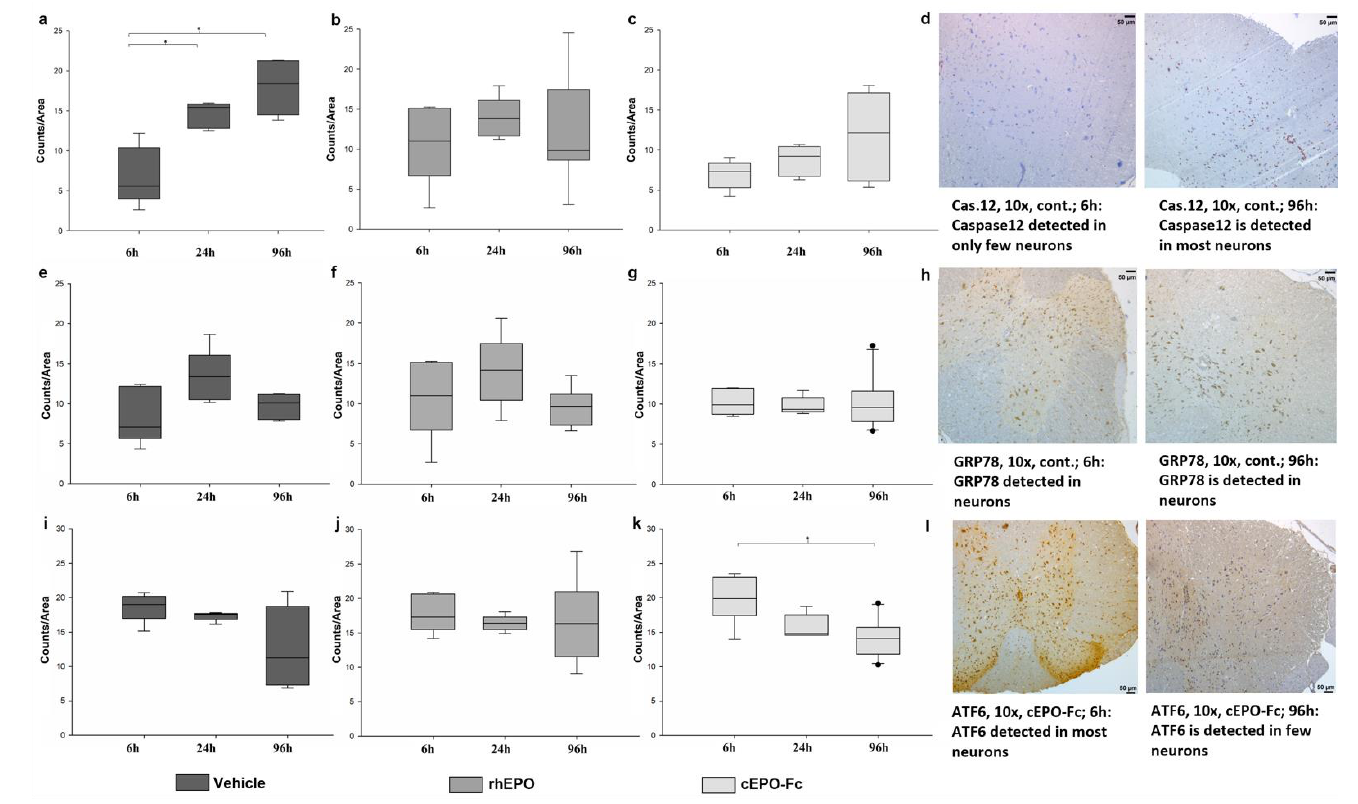
Figure 2. The results of the immunohistochemistry. The control group is in dark grey, the rhEPO group in semi-dark grey, and the bcEPO-Fc group is in light grey. Boxes indicate the upper and lower quartile, and the line indicates the median, and the upper and lower whisker indicate 2.5%- and 97.5% quantile, and black circles indicate values that are outside 2.5%- and 97.5% quantile. ( a ): Results of the immunohistochemical (IHC) evaluation of caspase-12 in the control group after 6 h, 24 h, and 96 h RT. * 6 h vs. 24 h p = 0.005 and 6 h vs. 96 h p < 0.001 (Multiple group comparison via